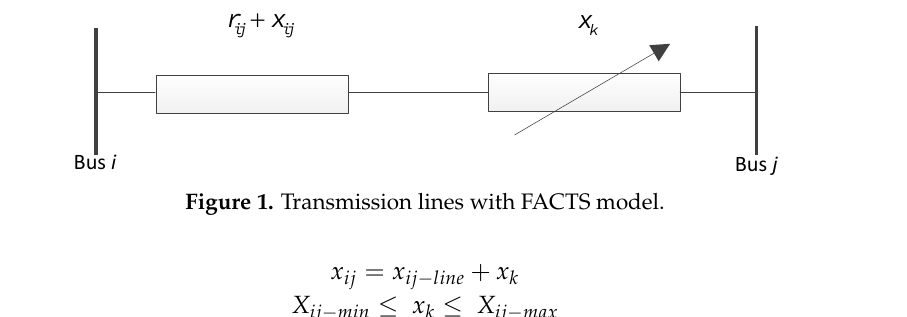
Figure 1. Transmission lines with FACTS